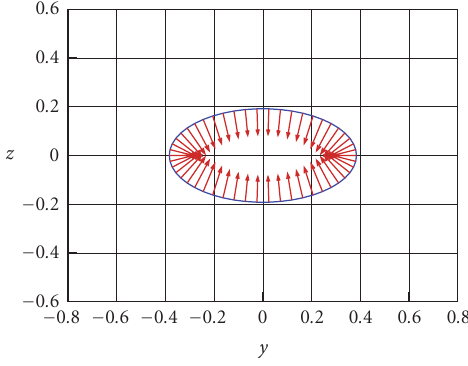
Figure 6.2. Normal stress ( T nn n y + T nn n z ) / 600dyn/cm 2 for an ellipse y 2 /b 2 + z 2 /c 2 = 1 − 2 . 9 2 /a 2 at x = − 2 . 9 cm in the ( y , z )-plane. Perpendicular view of the cross section (a) in Figure 6.1. The normal stress at the front of the ellipsoid gives rise to compression near the leading edge. This may explain the flat top observed in gas bubbles rising in viscoelastic fluids (see Figure 2.1).